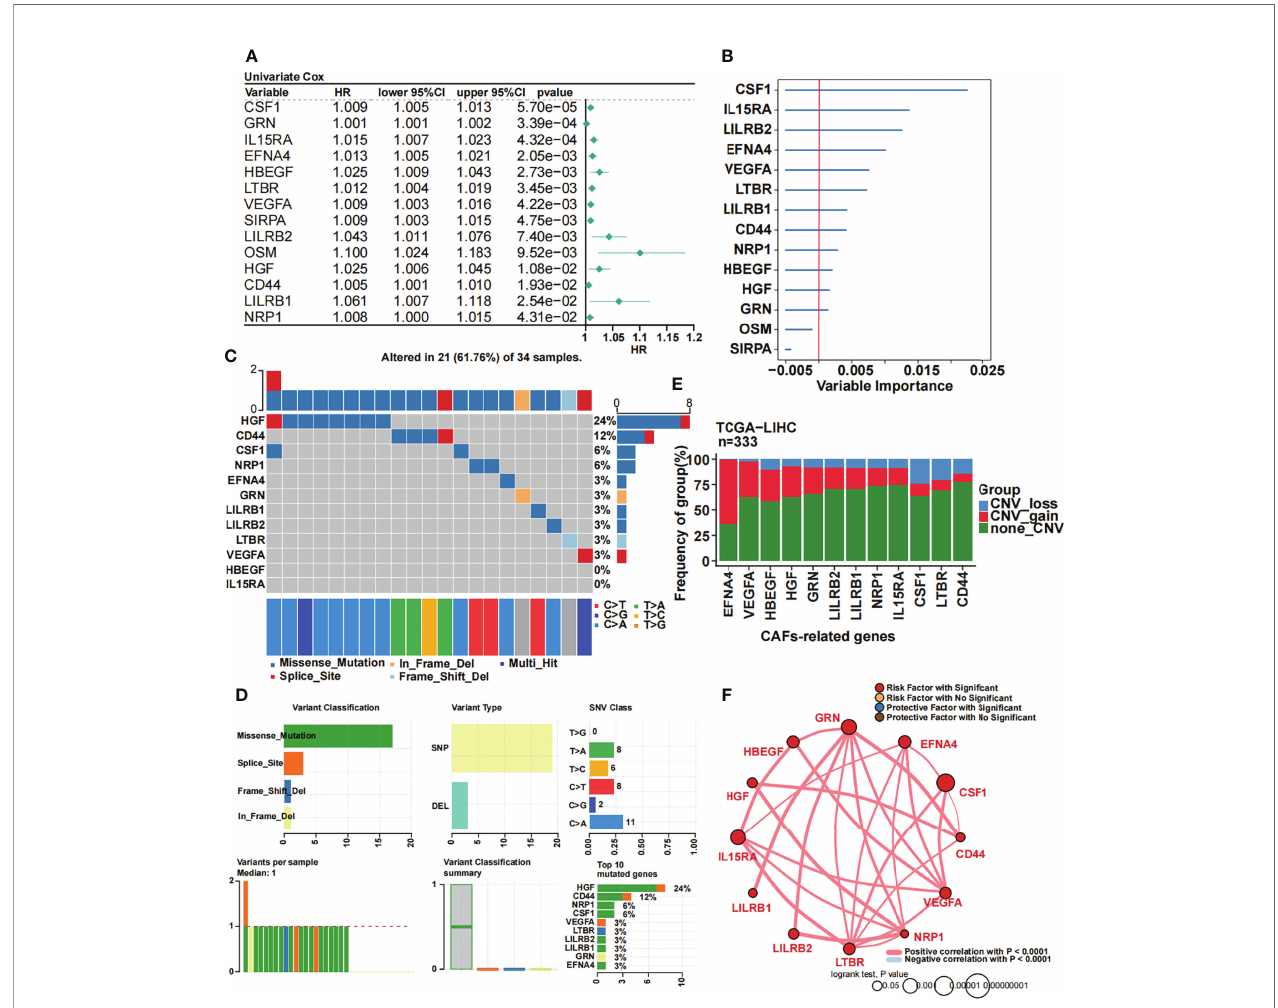
FIGURE 2 | Identi fi cation of 12 CAF-related prognostic genes. (A) Univariate Cox regression of CAF-related genes. (B) Random forest analysis of the candidate CAF-related prognostic genes. (C) The mutational landscape of 12 CAF-related prognostic genes. (D) Summary of the mutational analysis including variant classi fi cation, variant type, SNV class, variants per sample, variant classi fi cation summary, and the top 10 mutated genes. (E) The CNV status in 12 CAF-related prognostic genes. (F) Univariate Cox regression analysis and Pearson ’ s correlation of the 12 CAF-related prognostic